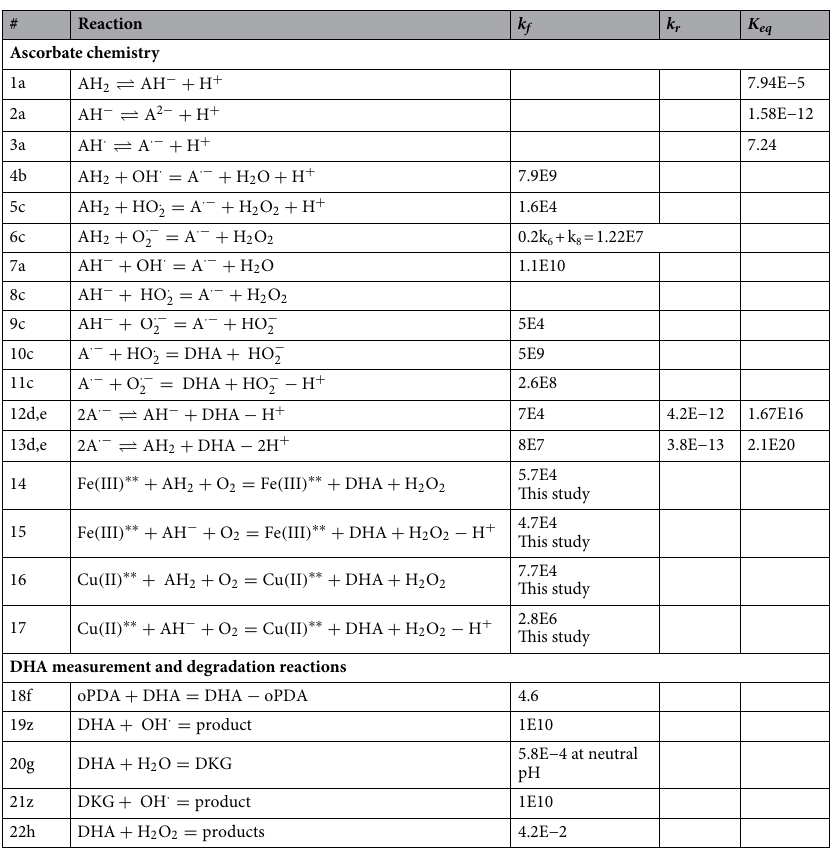
Table 1. Ascorbic acid model. Fe(III)** represents free Fe(III) species ( Fe Cu 2 + , CuOH + , CuSO 4 , CuCl + and CuCl 2 . These forward and back FeSO + Fe ( SO 4 ) − 4 and 2 ). Cu(II)** represents reactions are written separately in the KPP input file. a Buettner and Schafer 22 , b Redpath and Willson 21 , c Cabelli and Bielski 24 , d Van der Zee and Van den Broek 36 , e Bielski et al. 37 , f Vislisel et al. 57 , g Dewhirst and Fry 47 , h Parsons et al. 45 , z Estimate